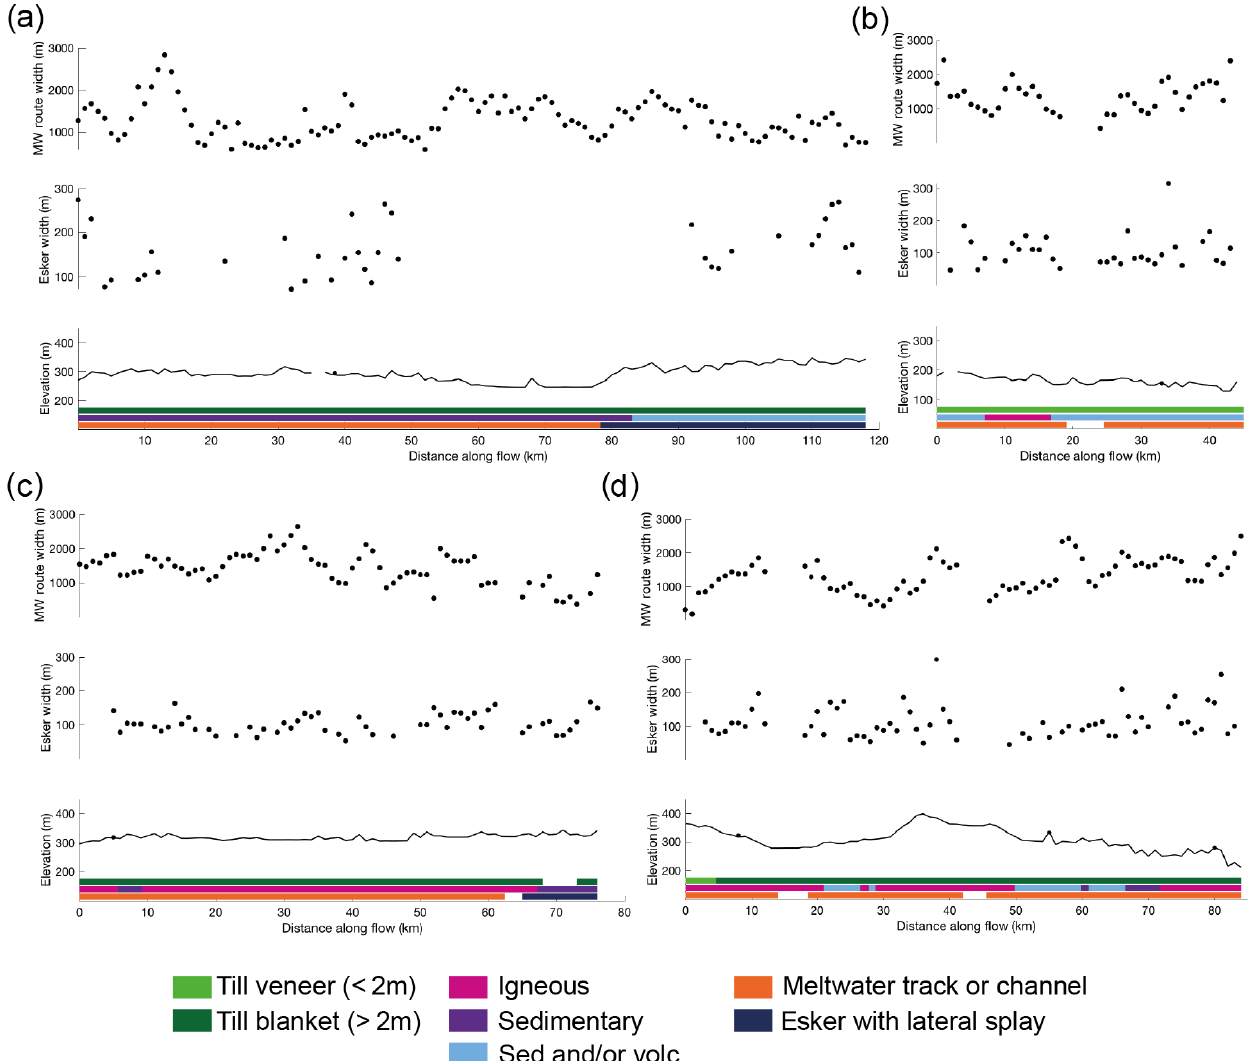
Figure 13. Exploring local-scale controls on meltwater route width and type. Detailed profiles (sampled at 1km intervals along individual meltwater routes; location identified in green in Fig. 5) show how esker width, elevation, feature expression and surface substrate vary along flow from the interior (left) to the exterior (right). Black points on the elevation plot represent the location of joining